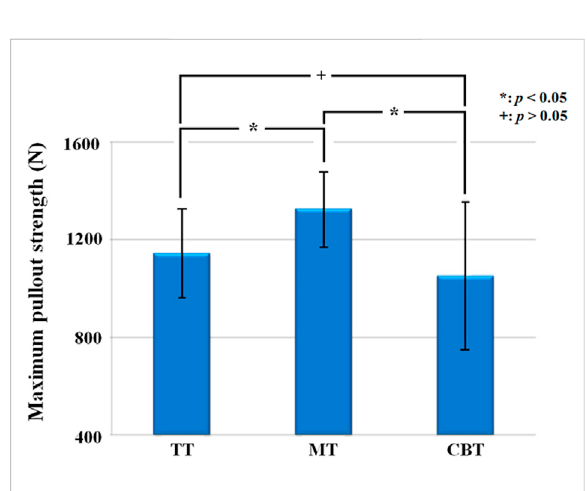
Mean maximum pullout strength of pedicle screws for a single vertebra treated with TT, MT and CBT trajectories. The maximumpulloutstrengthwassigni fi cantlyhigherintheMTgroup than in the TT and CBT groups. Signi fi cant difference was not observed between the TT and CBT different because of the anatomical characteristics (Lehman et al., 2003; Phan et al., 2015; Delgado-Fernandez et al., 2017; Hsieh et al., 2021a). Newcomb, et al. comparing varying pedicle screw orientations in the axial and sagittal planes on non-idealized fi nite element vertebrae found that